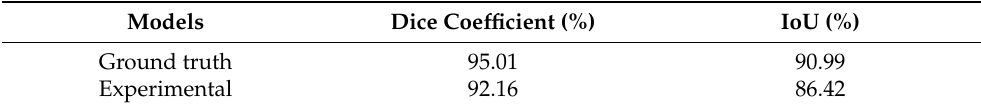
Table 2. Model performance with U-Net models trained with different segmentation